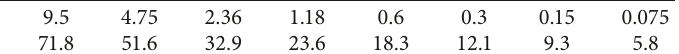
Table 1: Gradation of AC-13.